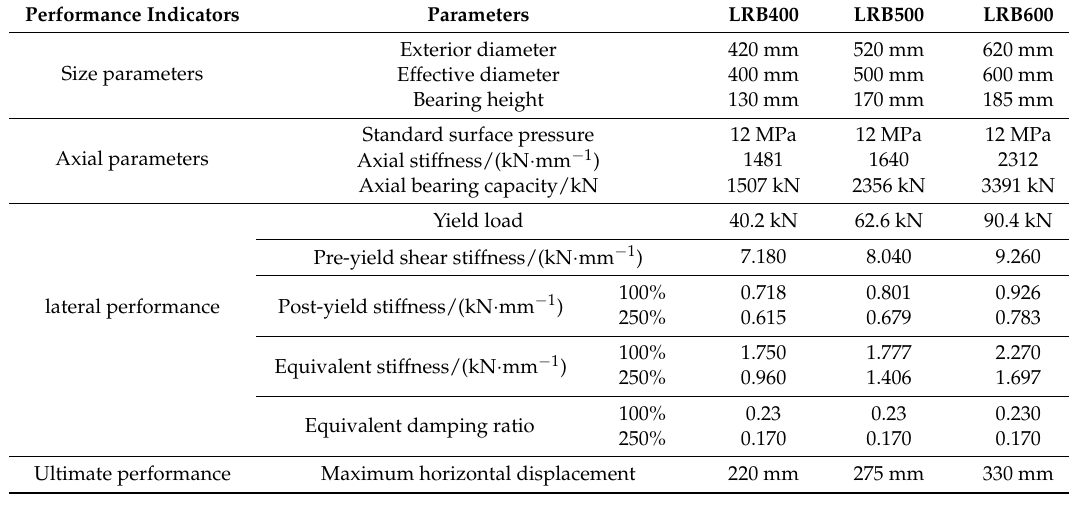
Table 1. Parameters of rubber isolation bearing.